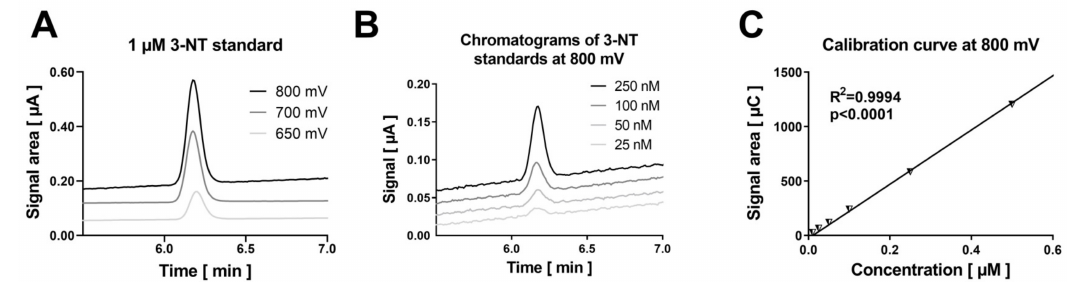
Figure 1. Detection of authentic 3-NT standards by HPLC / ECD. ( A ) The coulometric signal for 3-NT increased for the applied potentials from 650 to 800 mV as shown by the representative chromatograms. ( B ) The sensitivity of the HPLC / ECD analysis was good and a concentration of 25 nM 3-NT was easily detectable as shown by the representative chromatograms. ( C ) The calibration curve was highly linear over a concentration range of 10–500 nM. Analysis was carried on with 20 µ L of sample at 27 ◦ C with isocratic elution using a flow of 1 mL / min and a mobile phase consisting of 26.3 mM sodium citrate and